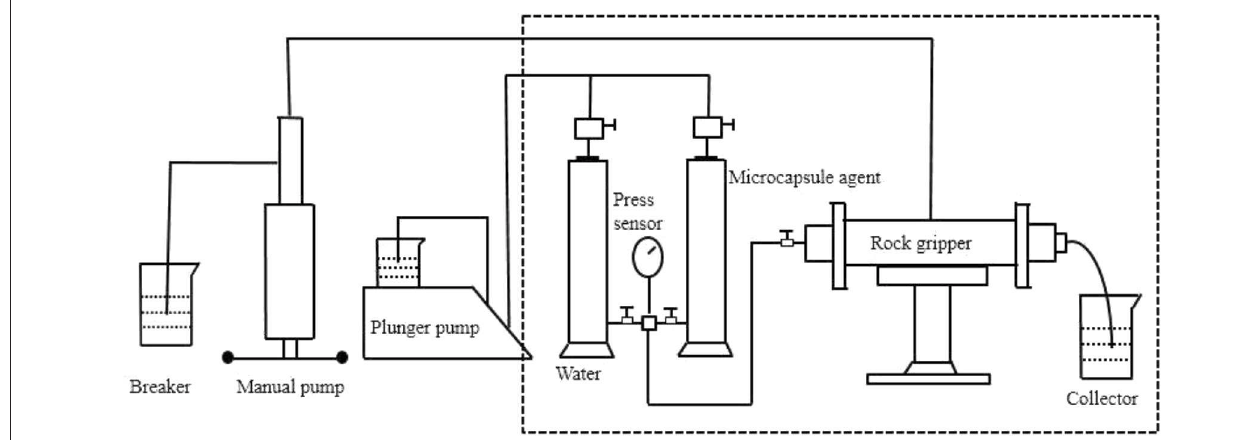
FIGURE 2 | Experimental device diagram.